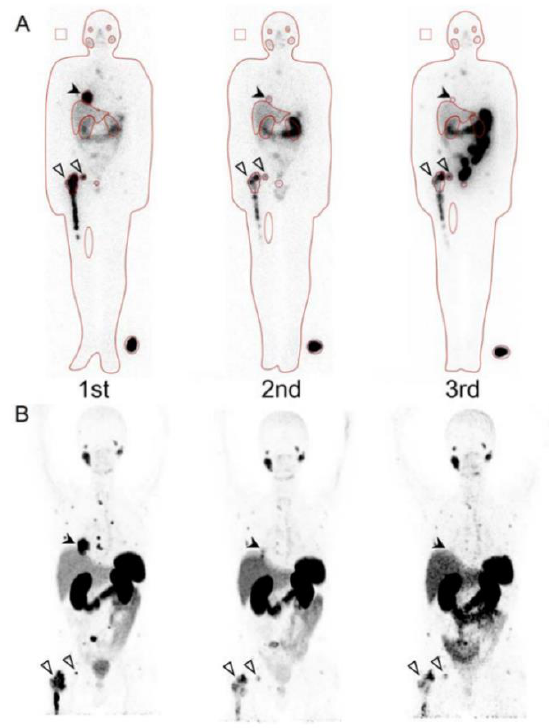
Figure 4. A patient with multiple metastases in lung (black arrow) and bone (white arrows): ( A ): Posttherapeutic Lu-177 prostate specific membrane antigen (PSMA) scintigraphy; ( B ): Pretherapeutic Ga -68 PSMA PET. Copyright 2017, with permission from J. Nucl. Med. [56].